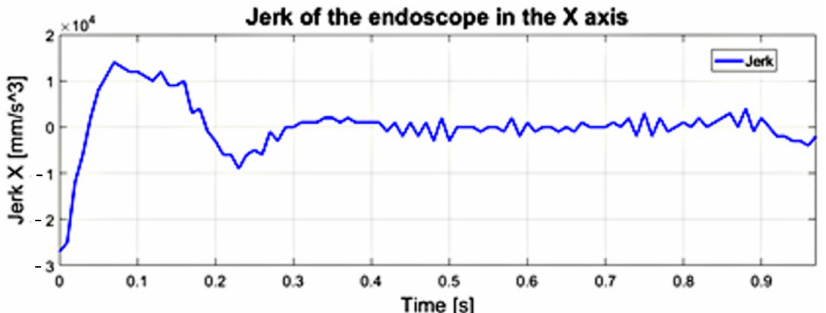
Figure 19. The jerk-like course of the endoscopic tool along the X − axis obtained on the basis of the course of acceleration—which is not constant in terms of